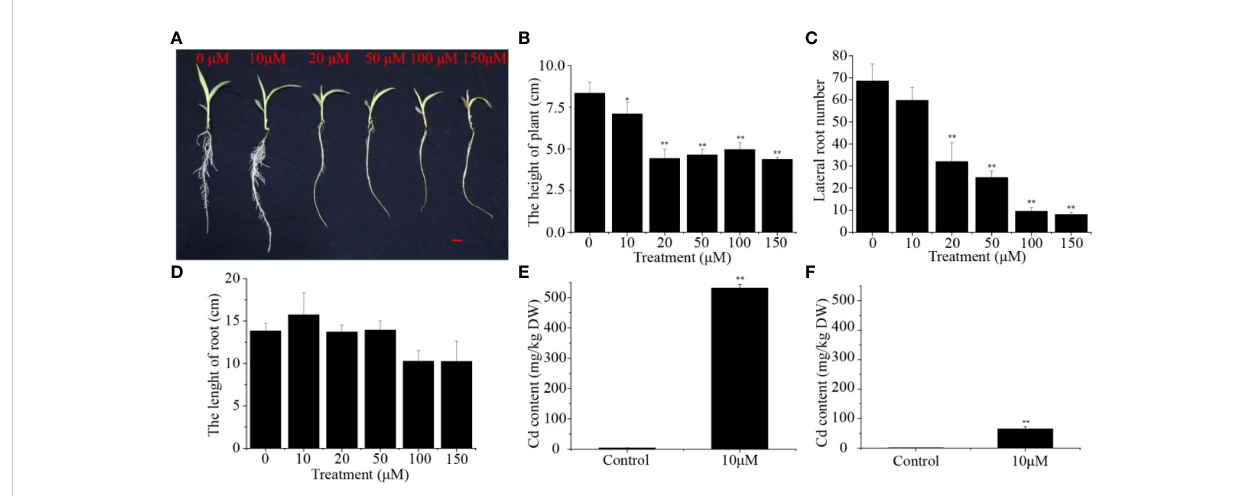
FIGURE 1 Effect of different Cd concentrations on (A) Phenotype, (B) Plant height, (C) The number of lateral roots and (D) Root length. (E) Cadmium concentrations in sorghum roots and (F) sorghum shoots under 10 m M Cd treatments. Asterisks denote signi fi cant differences (* P< 0.05 ; ** P< 0.01 ). Bars = 1